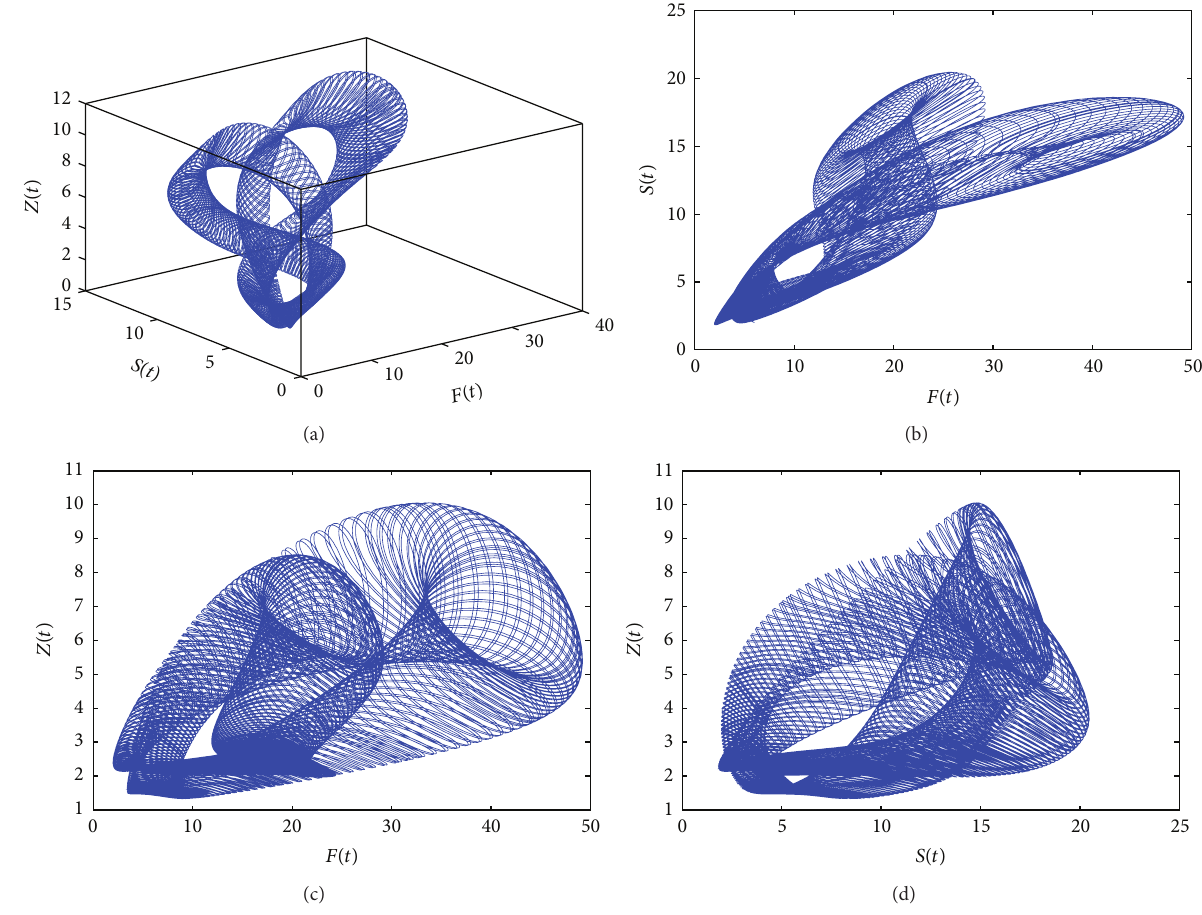
Figure 2: Chaotic behavior of system (1) with parameters in Example